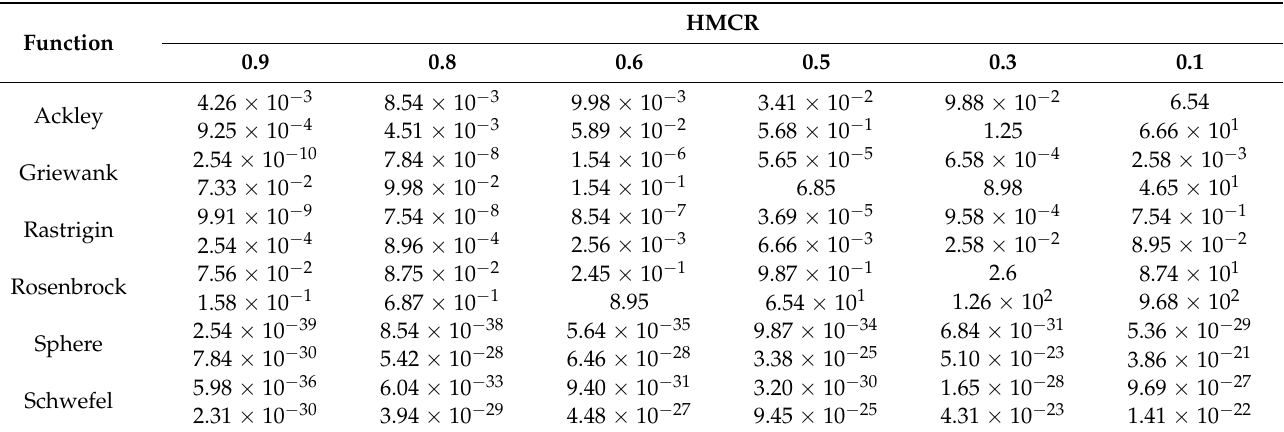
Table 3. Effects of HMCR on performance of RDEGA-HS (HMS =